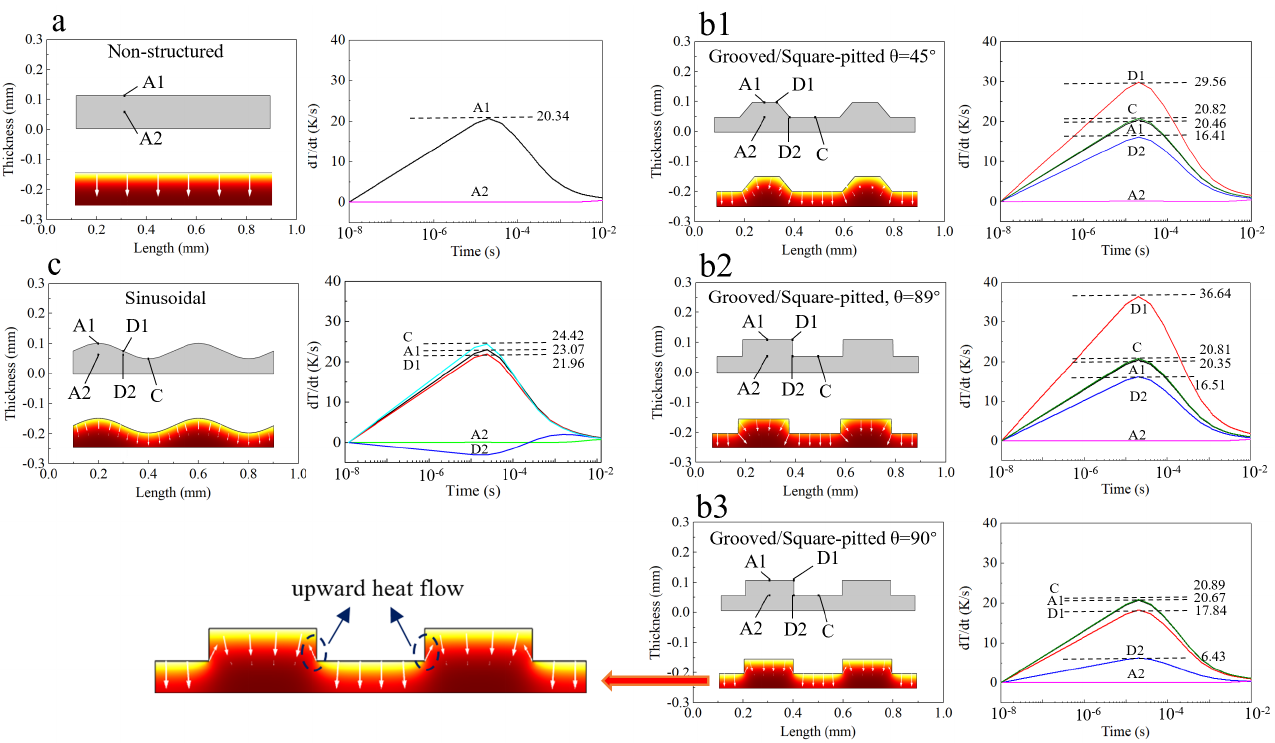
Figure 3. 2D models, heat flow and dT/dt at points of interest for the study of underlying mechanism of improved performance of: ( a ) non. ( b1 – b3 ) Grooved. ( c ) Sinusoidal.